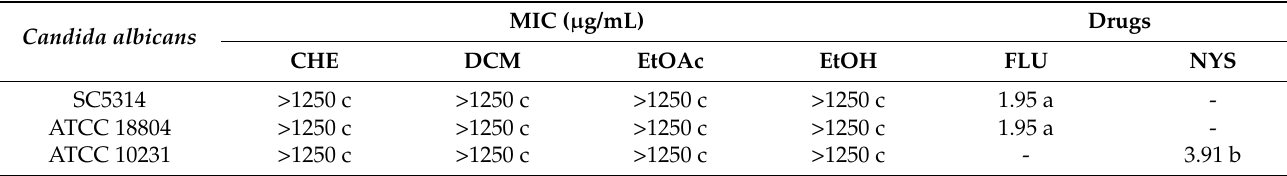
Table 3. Minimal inhibitory concentration (MIC) of extract and fractions of Bauhinia holophylla against Candida albicans strains. CHE: crude hydroethanolic extract; DCM: dichloromethane